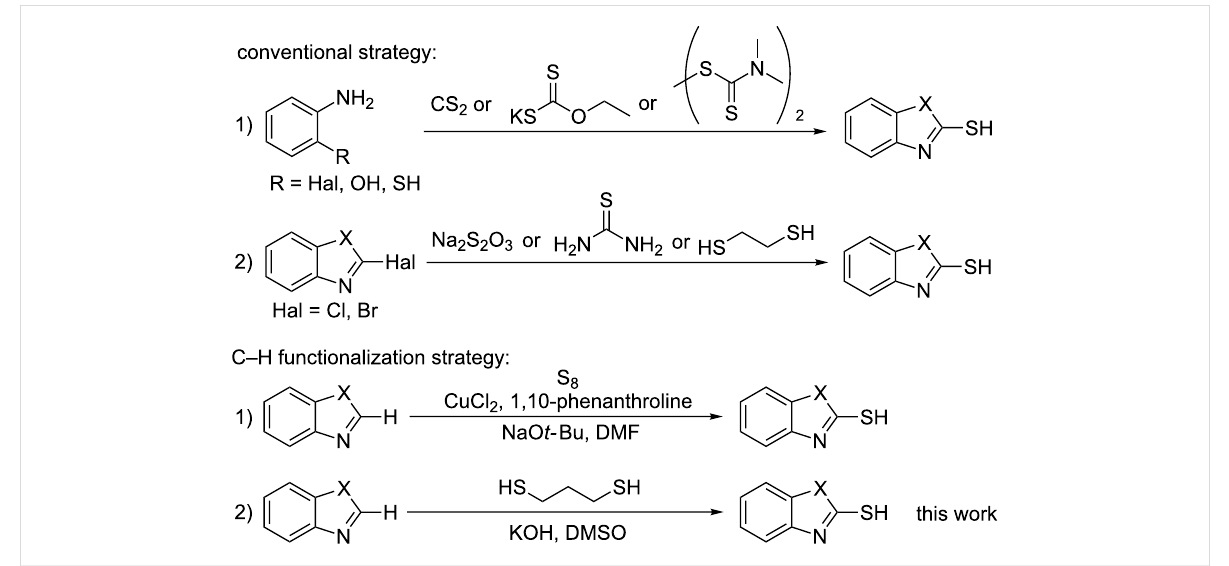
Scheme 1: Strategies for the synthesis of 2-mercaptobenzothiazole and 2-mercaptobenzoxazole (X = O, S).